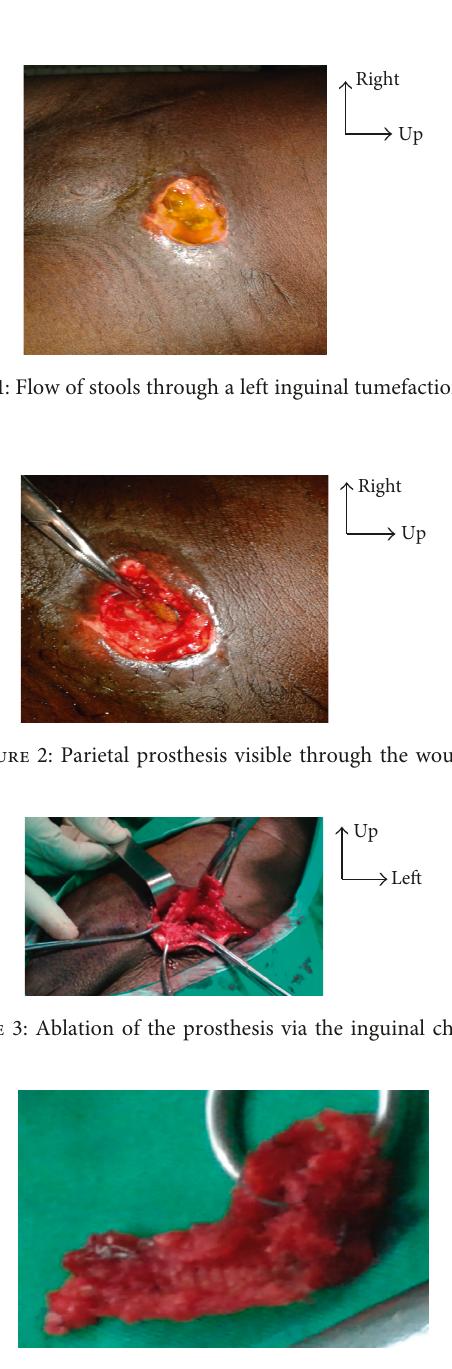
Figure 4: Parietal prosthesis after total ablation.